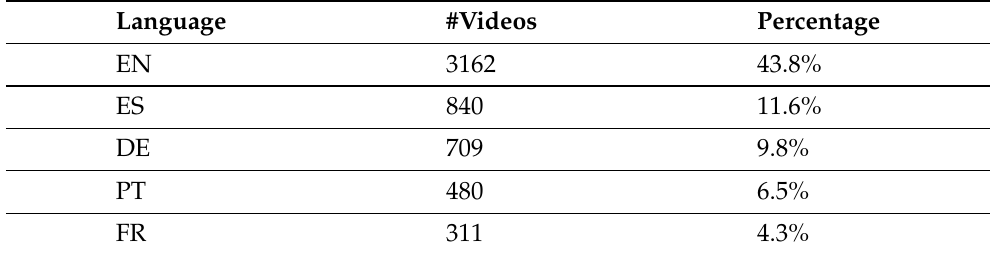
Table 2. Top 5 languages detected on the titles of the Oxford COVID-related misinformation dataset.